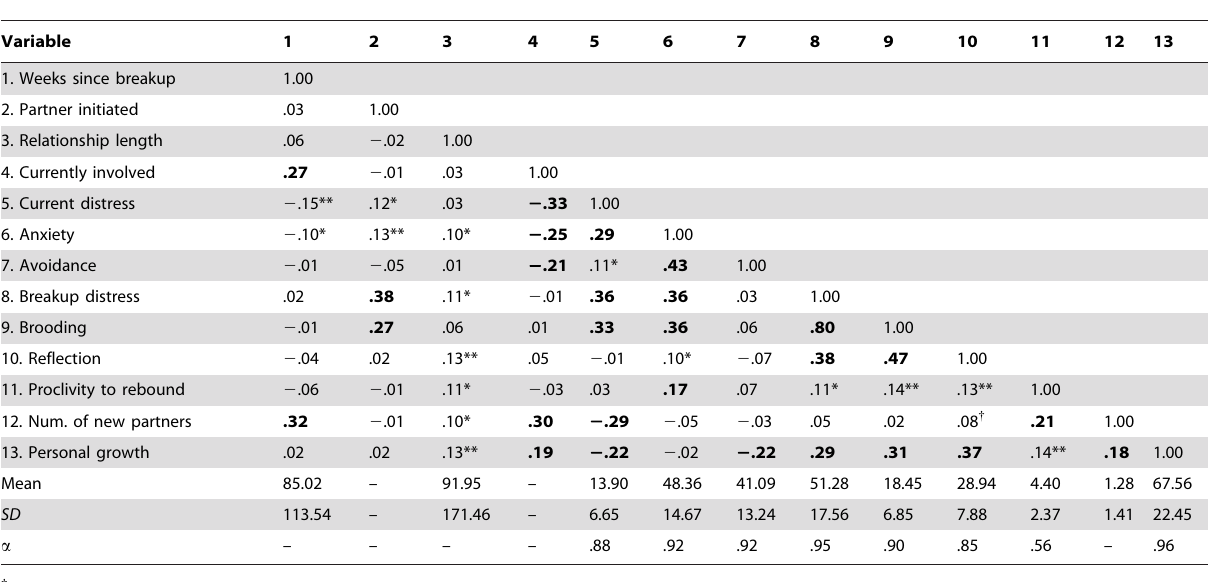
Table 2. Study 2: Descriptive statistics, Pearson’s correlations and Cronbach’s alpha coefficients.